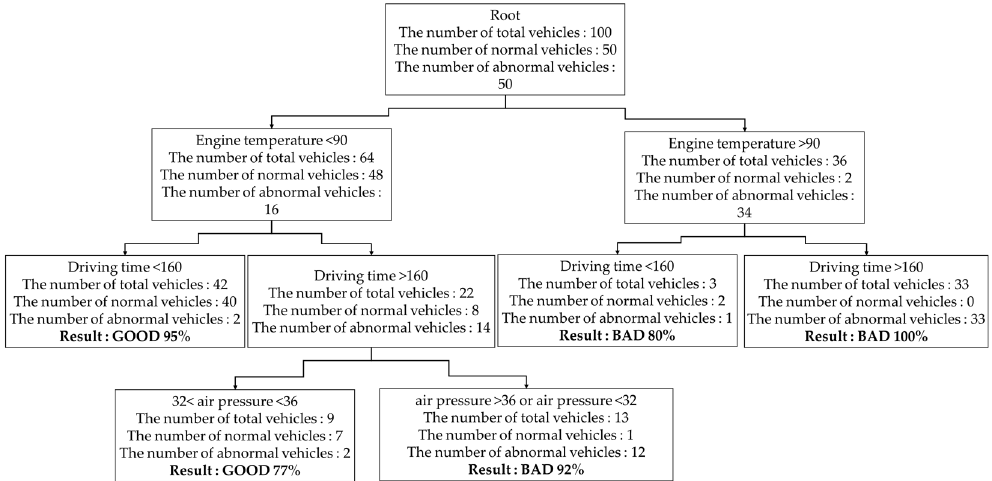
Figure 10. The decision-making tree generated based on the engine temperature, driving time, and air pressure.